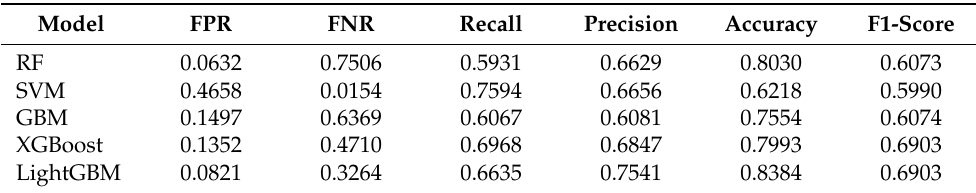
Table 7. Performance evaluation of machine learning models.